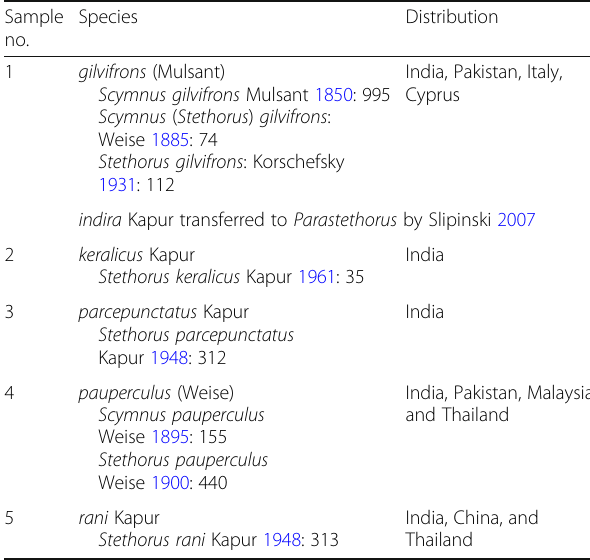
Table 2 Checklist of the genus Stethorus from India Sample